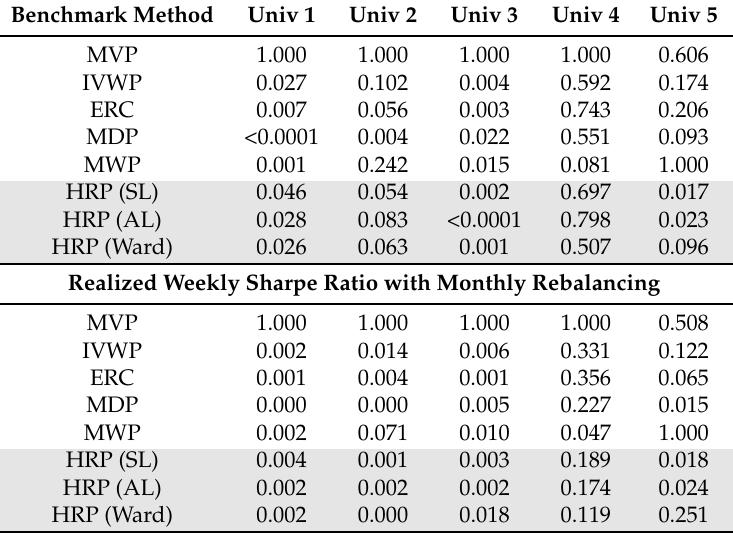
Table 9. p c -value for different choices of benchmark models when the loss function considered is negative of weekly Sharpe ratio and different rebalancing horizons are considered. The covariance matrix forecast is made using DCC-GARCH.